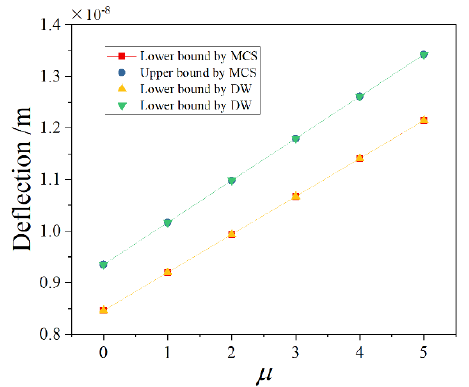
Figure 10. The deflection calculated by DW and MCS with different µ .